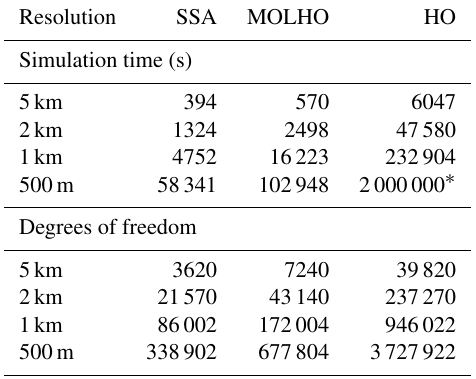
Table 5. Computational time to run the first 500 years of the MIS- MIP3D spin-up phase (Stnd). For comparison purposes, we show the simulation times obtained by three different ice flow models: MOLHO, HO, and SSA. SSA and HO employ the same mesh as MOLHO. For HO, we use 10 vertical layers. The number of ele- ments for each mesh resolution employed in MOLHO and SSA is shown in Table